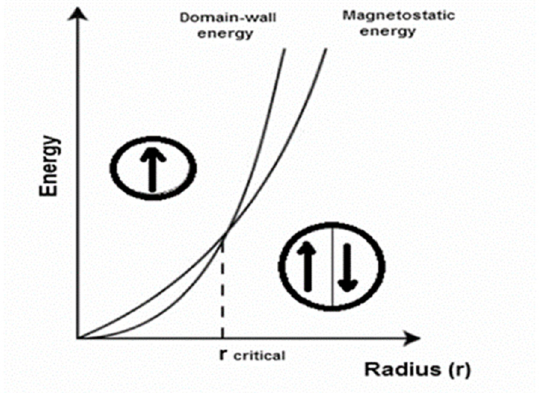
Figure 4. The relative stability of multidomain and single-domain particles. Reprinted with permission [78]. Copyright 2021, Cambridge University Press.